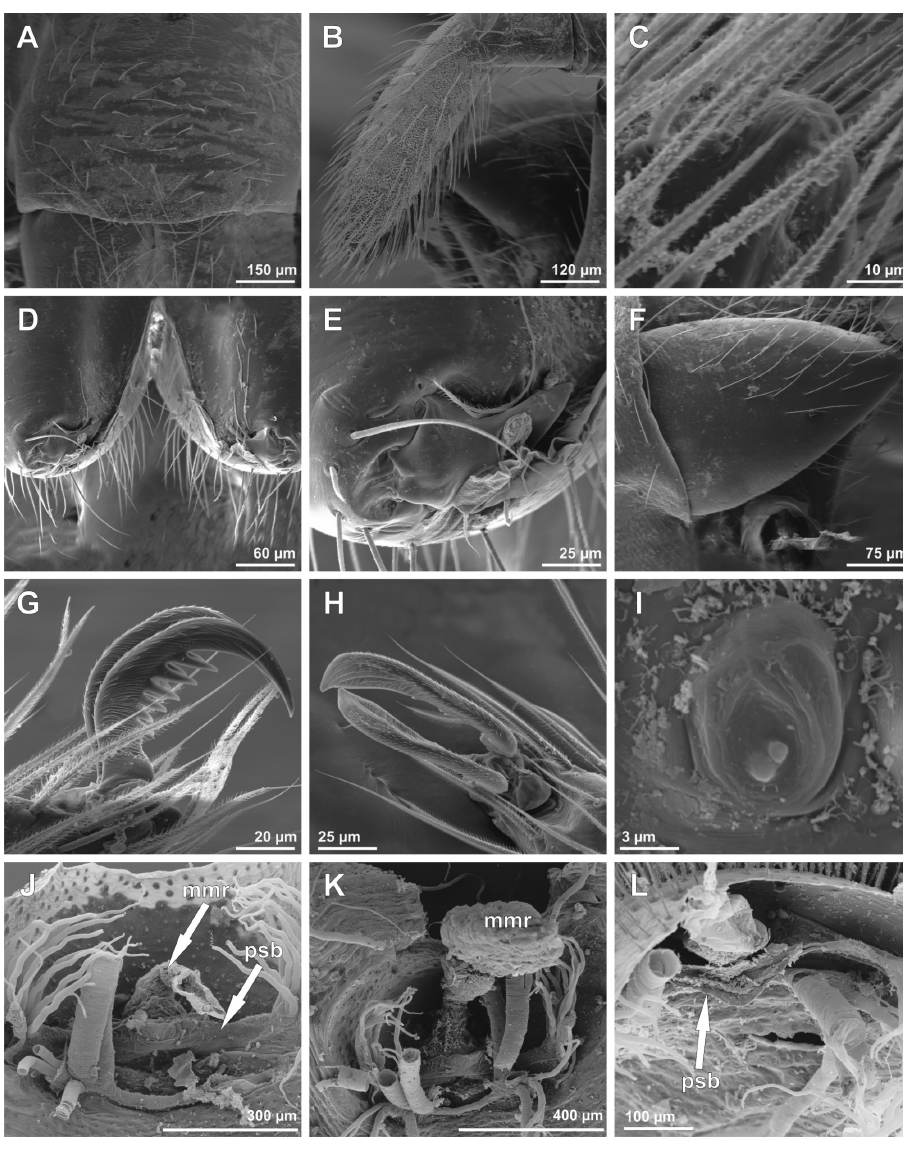
Figure 15. SEM images of Carajas paraua sp. n., three females (IBSP 161403) specimen 1 (A–J), speci- men 2 (K), specimen 3 (L) A carapace, ocular area, dorsal view B pedipalp, retrolateral view C same, dis- tal area, prolateral view D chelicerae, ventral view E same, distal area showing fang, ventral view F same, prolateral view G claws on left leg I, prolateral view H claws on left leg IV, dorsal view I tarsal organ on left leg IV, dorsal view J internal genitalia, dorsal view K same, dorsal view L same, anterior view (if = internal transversal fold; mmr = membranous anteromedian receptaculum; psb = pair of sclerotized